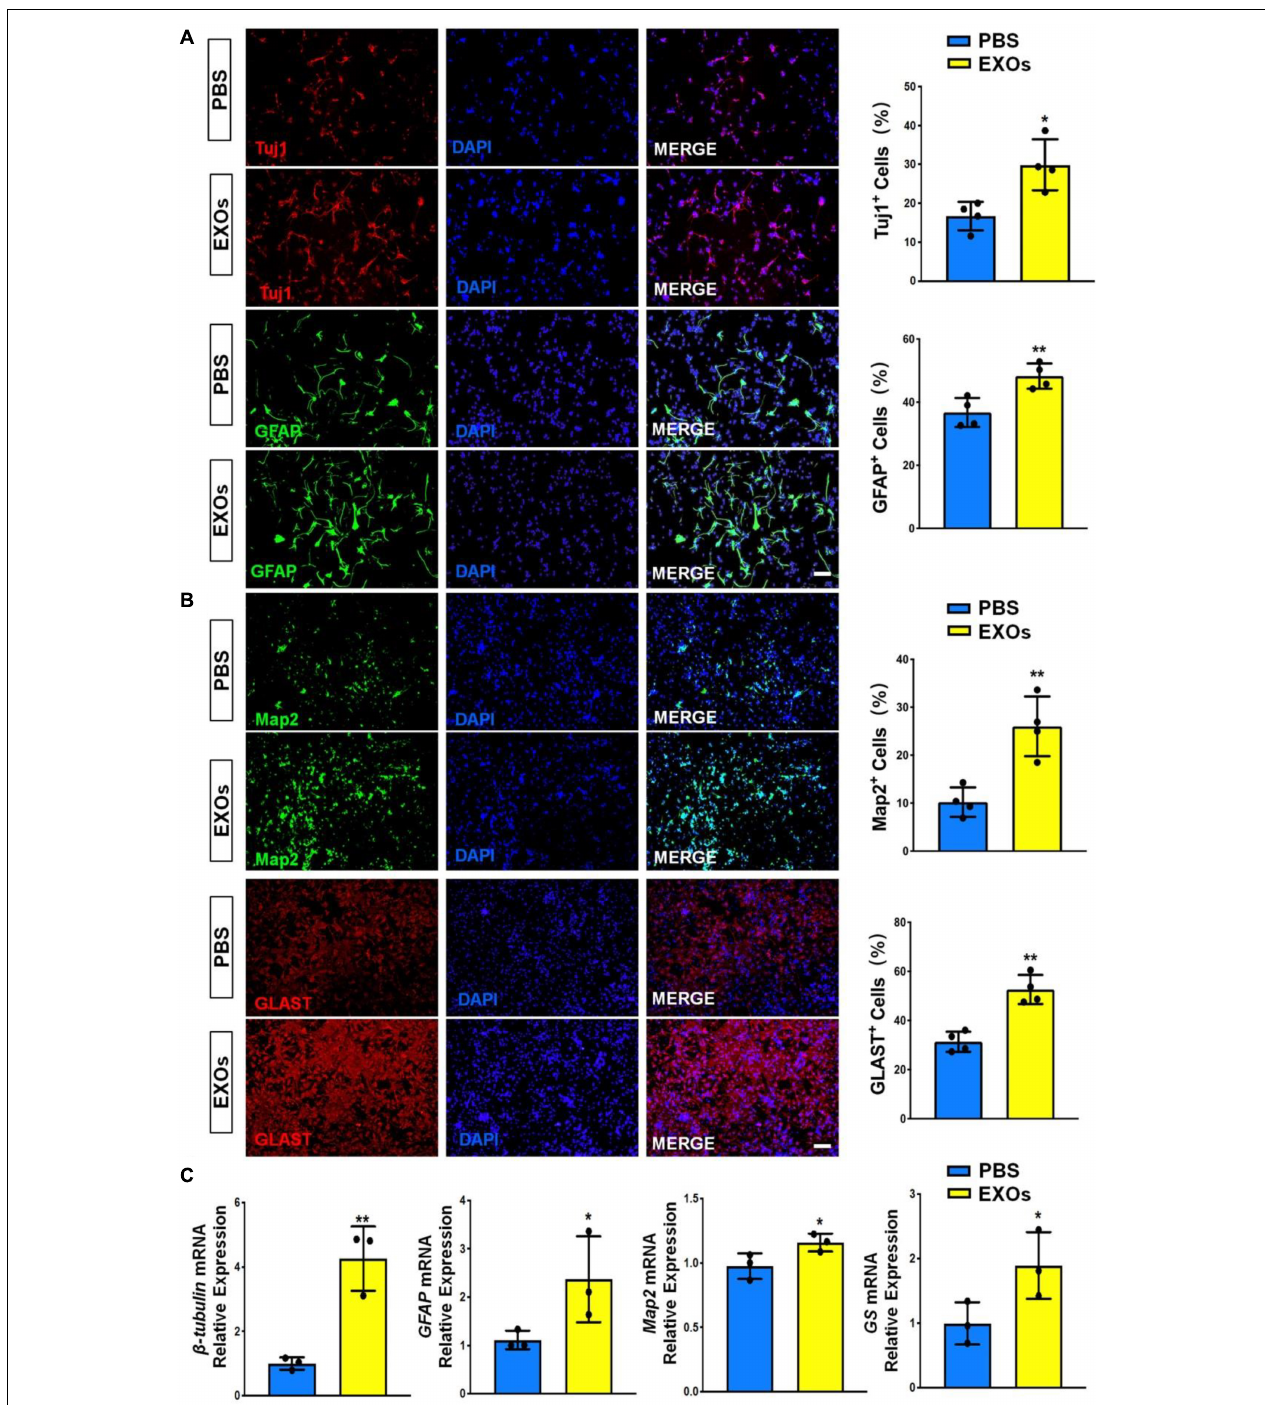
FIGURE 2 | Exosomes promote NSC differentiation. (A) NSCs were co-cultured with exosomes for 6 days in differentiation conditions. Representative images of pre-mature neuronal (Tuj1) and glial (GFAP) markers staining were shown. Proportions of cells expressing pre-mature cell-specific immunoreactivities were determined (in the right panel). (B) Representative images of matured neuronal (Map2) and glial (Glast) staining were shown. Proportions of cells expressing matured cell-specific immunoreactivities were determined (in the right panel). (C) The transcript expression of pre-mature cell markers ( β III-tubulin and GFAP ) and matured cell markers ( Map2 and GS ) was determined by RT-qPCR analysis. Data were represented as mean ± SE from three independent experiments. * and ** denote p < 0.05 and p < 0.01, respectively. Scale bar 100 µ m in panel (A,B) .